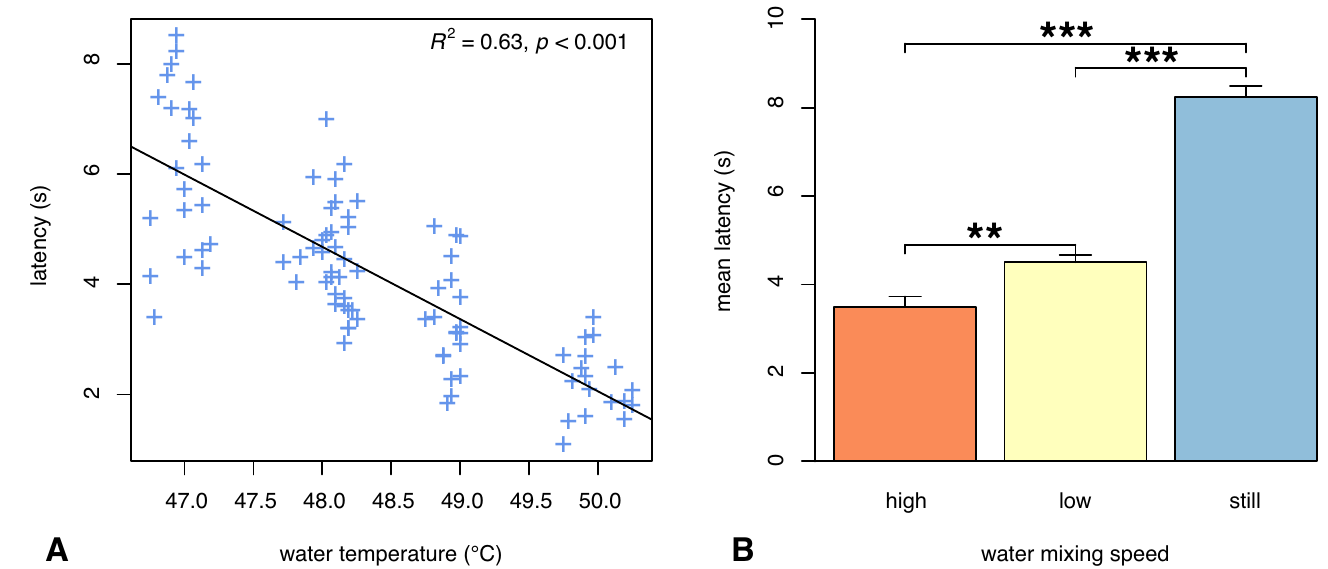
Fig 2. Latency varies across water conditions. [ A ] Tail withdrawal latency measured at different water temperatures. Each data point (+) represents one of the 2–3 latency measures obtained for each individual rat at each temperature tested. As water temperature is decreased, latency is lengthened. Linear regression indicated that temperature explains 63% of the variance in latency when tested between 47–50˚C with the water mixing at a constant, low speed. [ B ] Tail withdrawal latency measured at a constant temperature (48˚C ± 0.25) and different water mixing speeds. Lengthening of latency occurs as the water mixing speed is decreased with the longest latencies occurring when the water is still (i.e., not being mixed by the stir bar). Data are expressed as mean ± SEM; �� p = 0.001, ��� p <